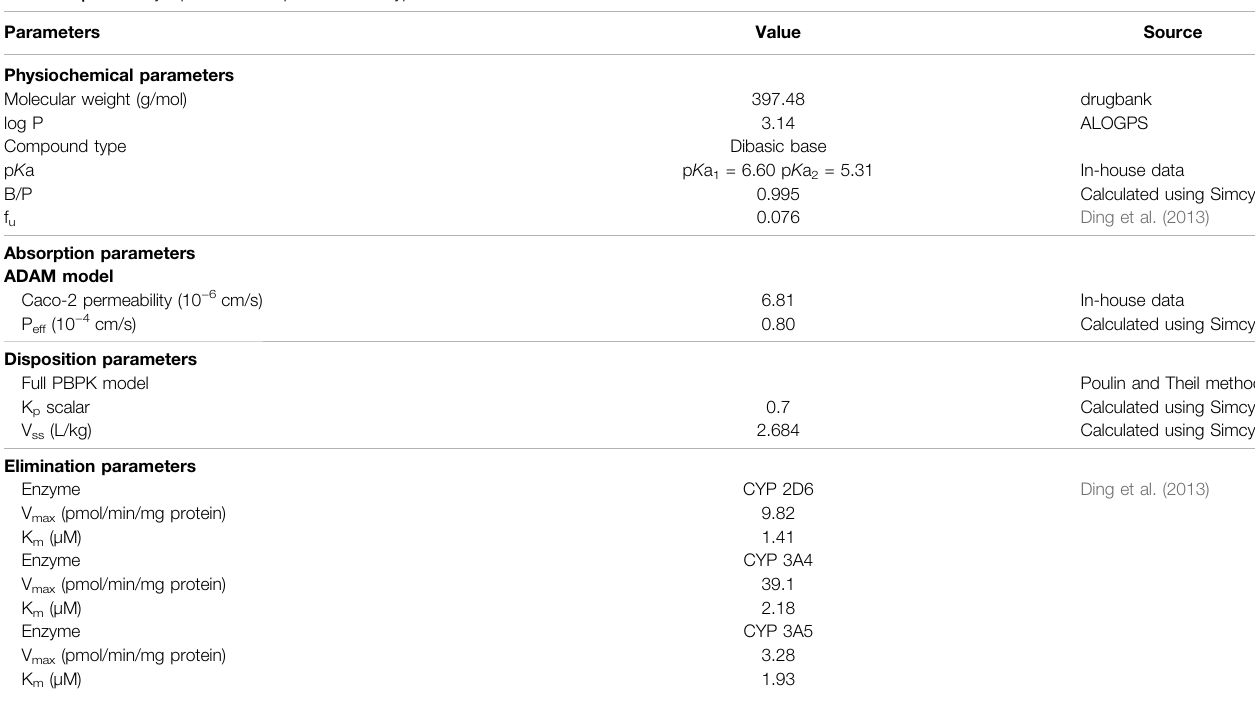
TABLE 1 | Summary input data for apatinib in Simcyp Simulator simulation